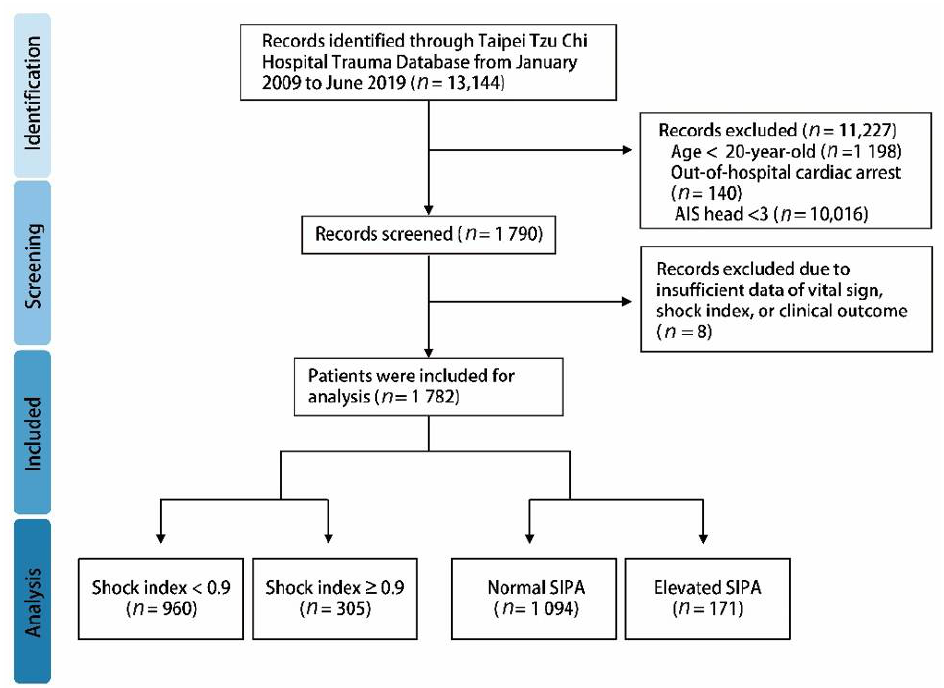
Figure 1. Schematic diagram illustrating the detailed inclusion of pediatric trauma patients. Table 2. Demographic population of all pediatric trauma patients.